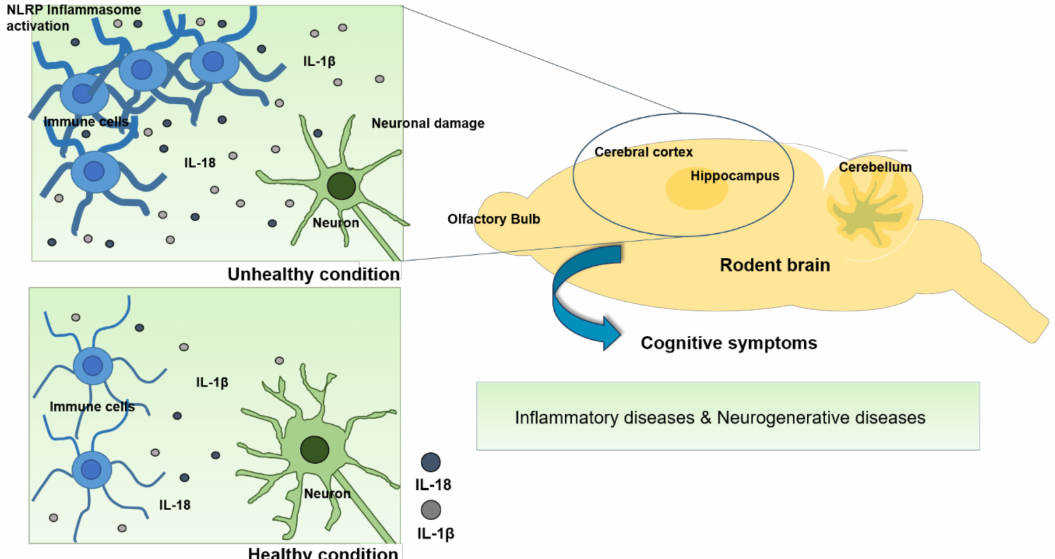
Figure3. Imbalancedordysregulatedinflammasomesarelinkedtoinflammatory,andneurodegenerative diseases. In these diseases, activation of inflammasome complex and pro-inflammatory cytokines IL-18 and IL-1 β in immune cells are involved in neuronal damage and degeneration in the brain, in particular, hippocampus and cerebral cortex. These outcomes may be related to cognitive symptoms. Therefore, understanding the inflammasome regulatory mechanisms may be required for the prevention and treatment of cognitive